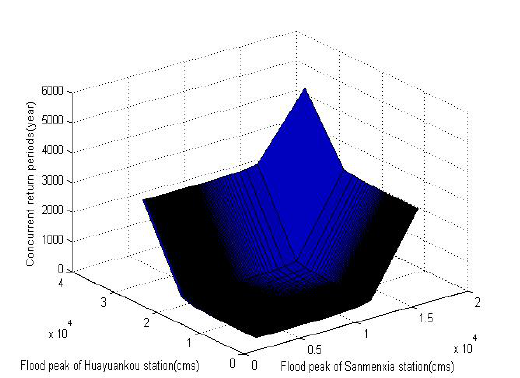
Fig. 9. Concurrent return periods between the annual maximum flood magnitudes of Sanmenxia and